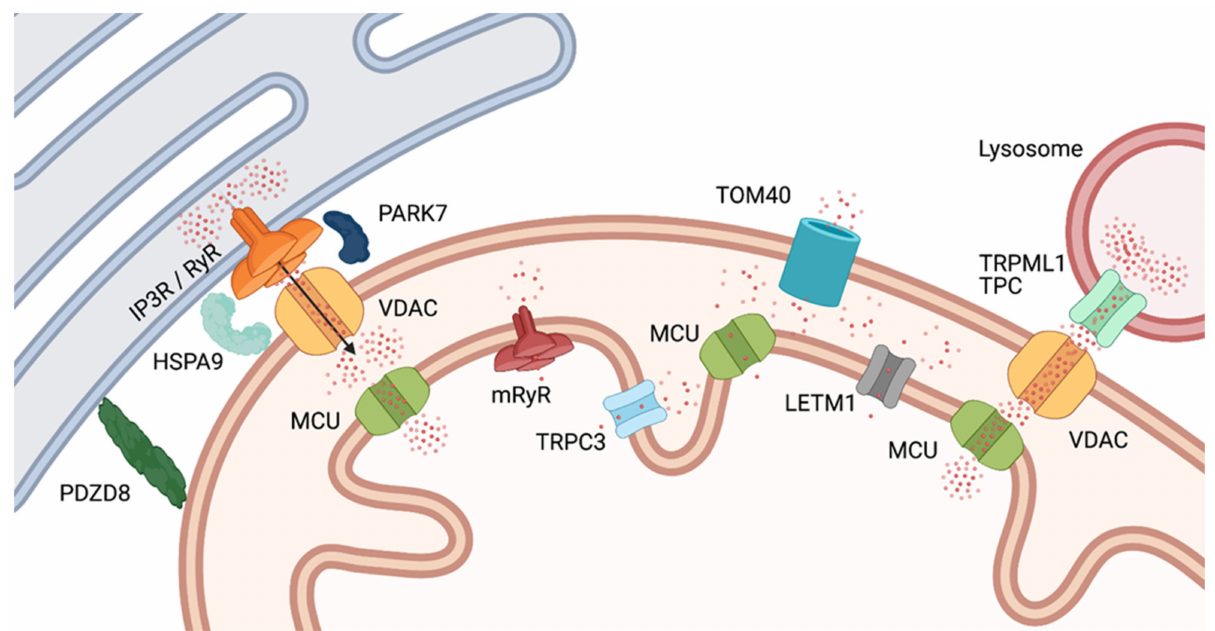
Figure 3. Calcium gradients at MAM microdomains. At ER-mitochondria ( right ) and lysosome-mitochondria ( left ) contacts, Ca 2+ concentration reaches levels that allow efficient import through MCU. The ER MAM provides colocalization between the Ca 2+ release receptor (through HSPA9 and PARK-7) and VDAC1. Ca 2+ (represented by red dots) flowing through the receptor will thus enter the IMS readily. Lysosome-mitochondria contacts serve a similar purpose, the Ca 2+ source being in this case TRPML7 channels. At other locations, IMS Ca 2+ will reach lower concentrations, and transport through MCU will be less efficient. For abbreviations and definitions, see